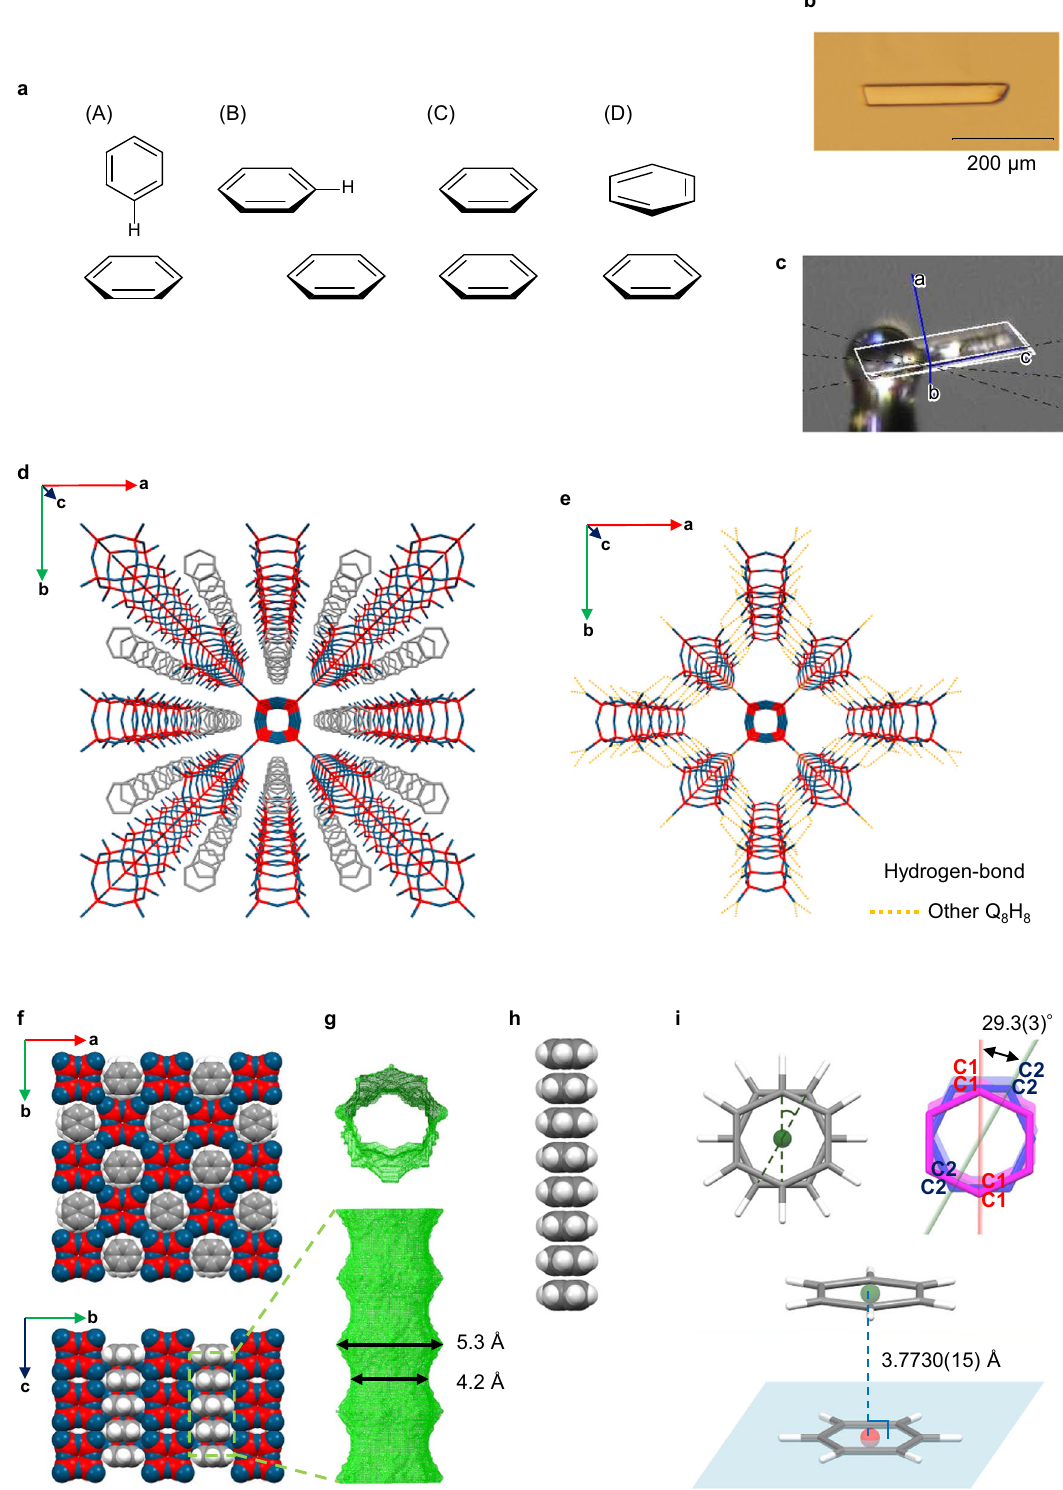
Fig. 4 Geometries of benzene dimers and crystal structures of 3D ⊃ benzene determined by single-crystal X-ray diffraction. The hydrogen atoms in the 3D crystal packing representations have been omitted for clarity. Color code: Si = red; O = blue; C = gray; H = white. The green and red points are the centroids of the guest molecules, and the light blue plane passes through a guest molecule. The dashed line color scheme is as follows: Hydrogen bonds between Q 8 H 8 molecules: orange; twist angle: green; line vertically connecting a centroid to the molecular plane of another guest: blue. a Geometries of benzene dimers: (A) T-shaped, (B) parallel-displaced, (C) parallel- D 6h , and (D) parallel- D 6d . b polarized micrograph and c crystal photograph with cell axes, which were drawn by CrysAlisPro software; d 3D crystal packing; e hydrogen-bonding interactions; f 3D space- fi lling representation; g visualization of the solvent-accessible surface of the one-dimensional pores calculated using the software Olex2; h partial space- fi lling views of the stacked guest molecules; i top view and diagonal view of the geometry of the stacked guest